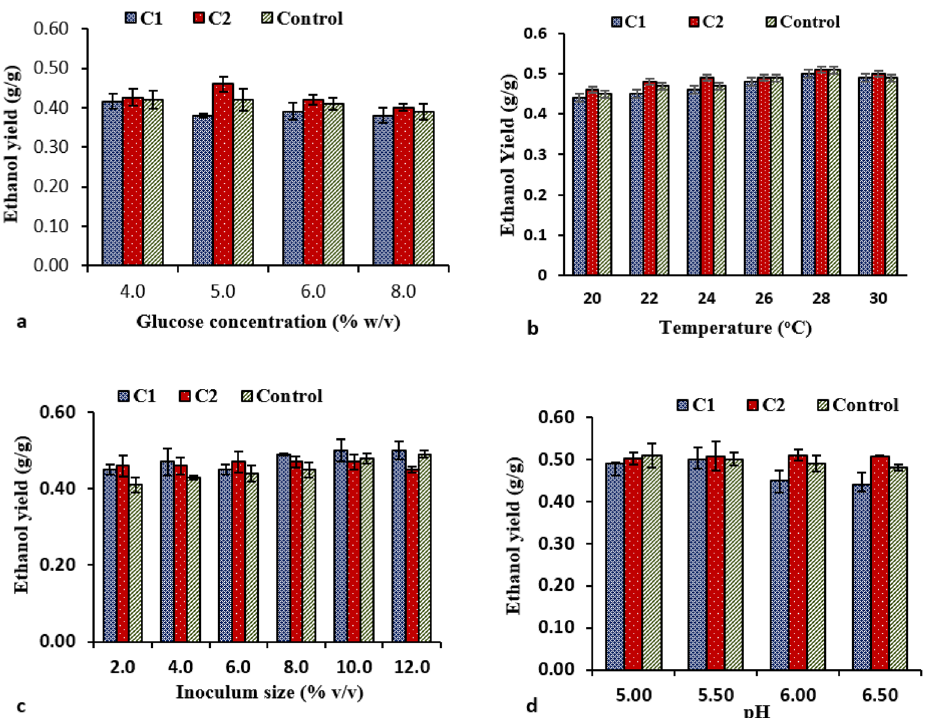
Figure 2. Fermentation process parameters optimization using control strain and strains isolated in this study (C1, C2) ( a ) Glucose concentration ( b ) Temperature ( c ) Inoculum size ( d ) pH. C1: Saccharomyces cerevisiae CMS11; C2: Saccharomyces cerevisiae CMS12; Control: commercial culture of Saccharomyces